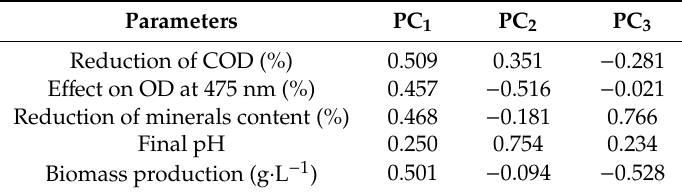
Table A2. Eigenvectors obtained from PCA.